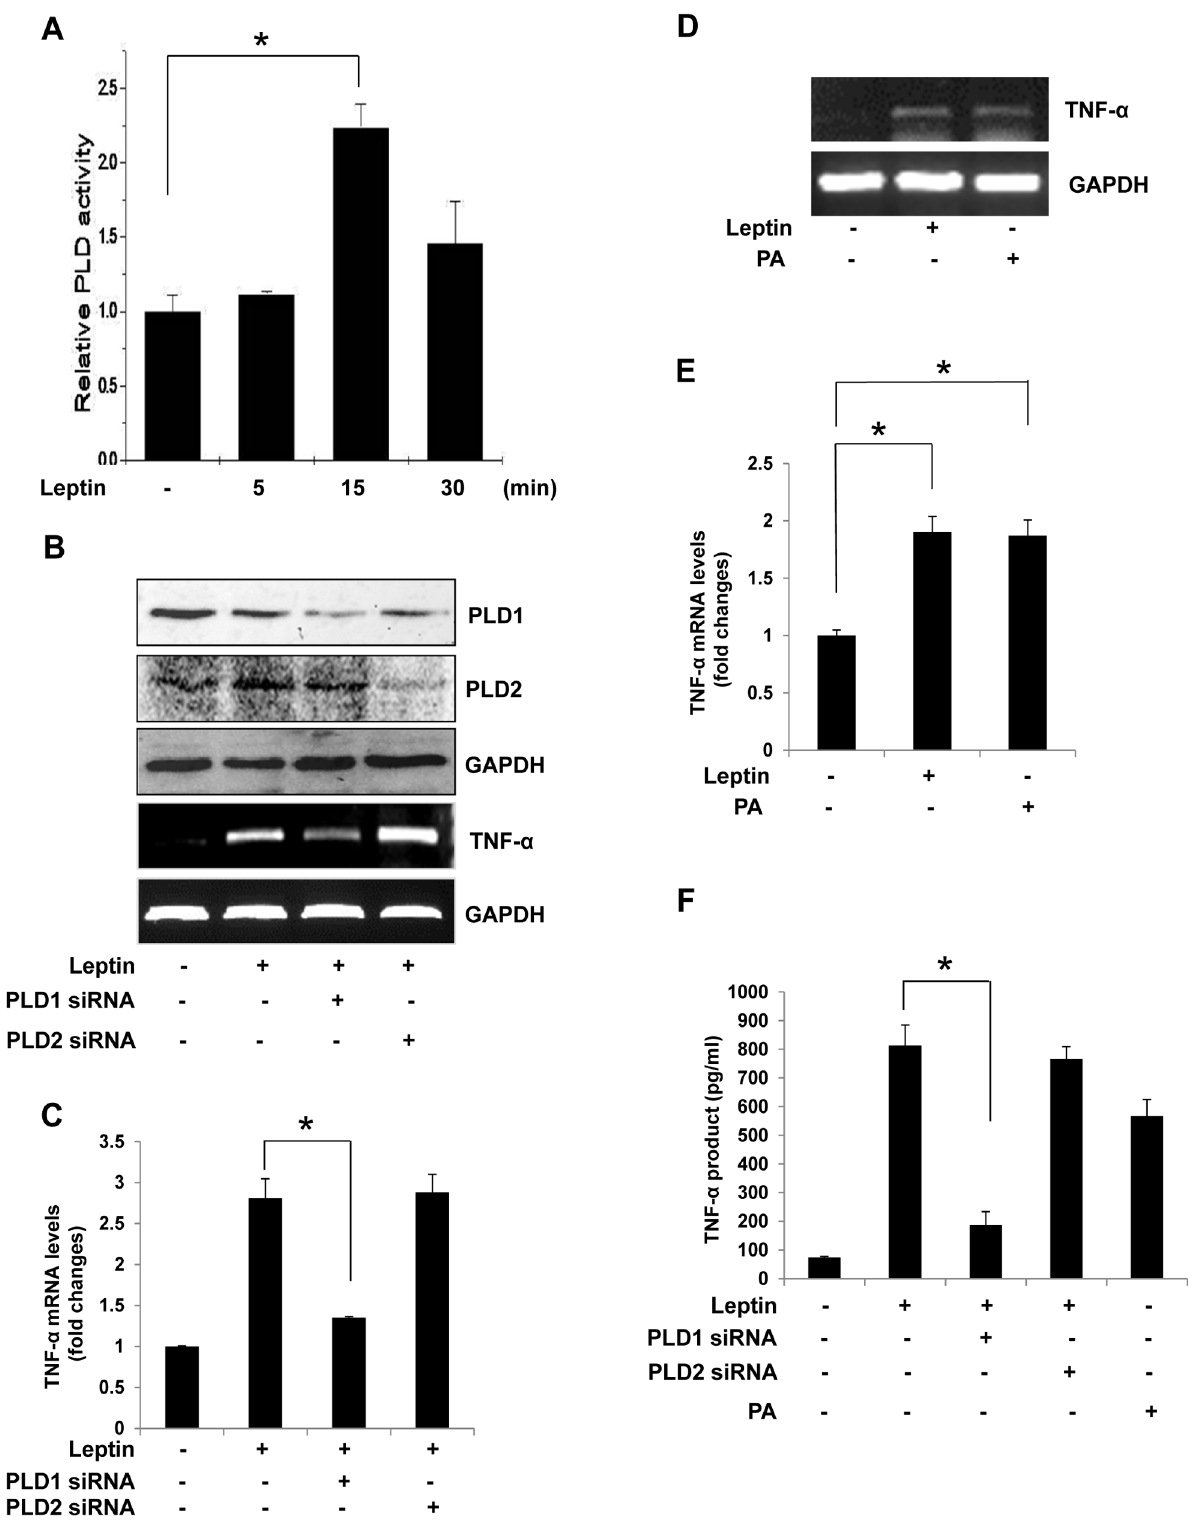
Figure 2. Effect of PLD knockdown on leptin-induced TNF- a expression in Raw 264.7 cells. (A) Raw264.7 cells were labeled with 2 m Ci/mL [ 3 H]-palmitic acid and stimulated with leptin (20 nM) for the indicated times. PLD activity was determined by estimating the amount of [ 3 H]-PBt in the presence of 1-butanol. Results are the mean 6 S.D. of three independent experiments. *p , 0.05 vs control. (B,C) Raw264.7 cells were transiently transfected with 200 nM PLD1 siRNA or PLD2 siRNA for 48 h and were stimulated with leptin (20 nM) for 30 min. Cells lysates were subjected to Western blotting. The cells were harvested and total RNA was isolated using TRIzol reagent, and mRNA levels were determined by semi-quantitative and real-time RT-PCR with primers for TNF- a or GAPDH. *p , 0.05 vs leptin-treated control. (D,E) Cells were treated with leptin (20 nM) or PA (10 m M)